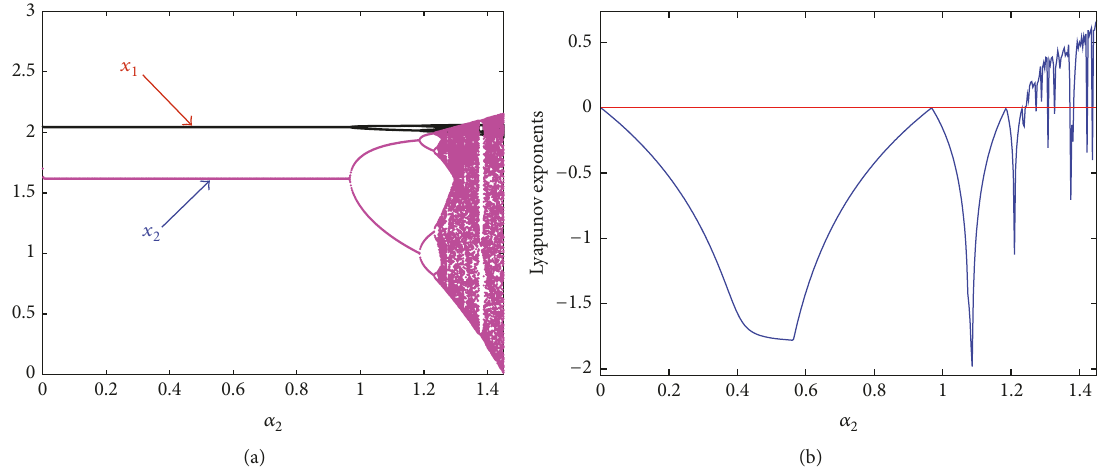
Figure 7: Bifurcation diagram (a) and corresponding largest Lyapunov exponents (b), with 𝛼 2 ∈ (0,1.4510] for 𝛼 1 = 0.42 .